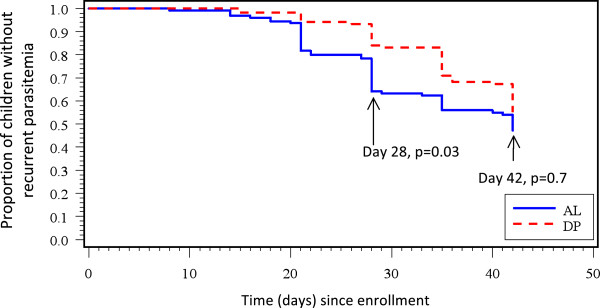
Survival curve of enrolled children by PCR-uncorrected data, western Kenya 2011. Legend: This graph is using intention to treat (ITT) analysis.